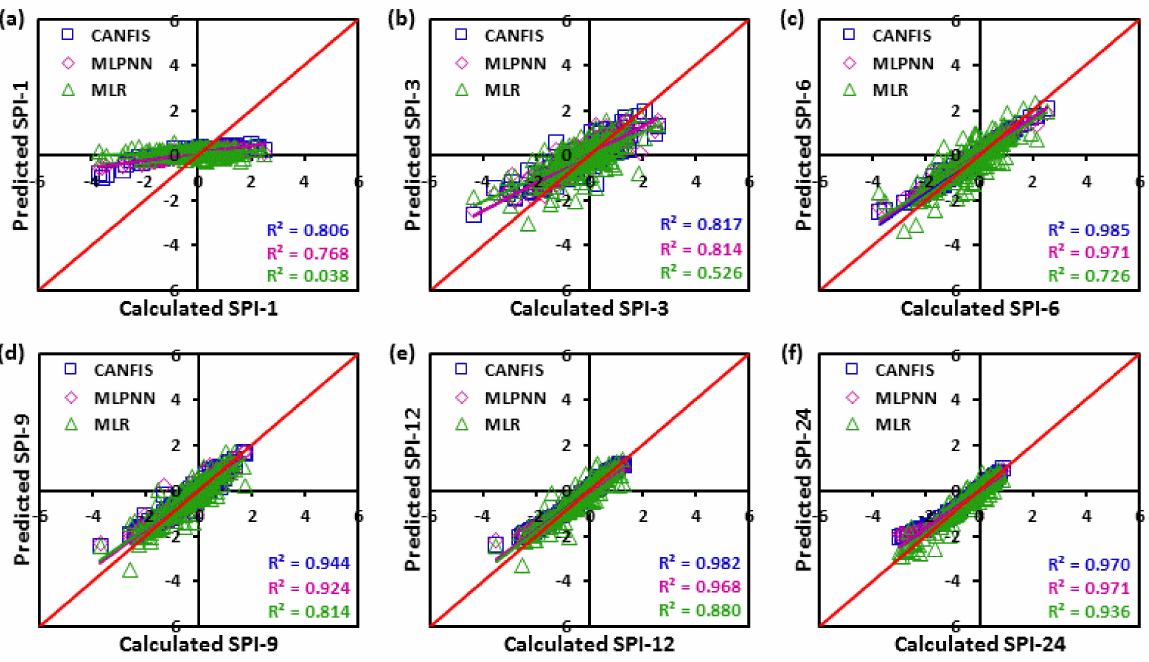
Figure 9. ( a – f ) Scatter plots of calculated and predicted multi-scalar SPI values by CANFIS, MLPNN, and MLR models during the Tehri Garhwal station’s testing